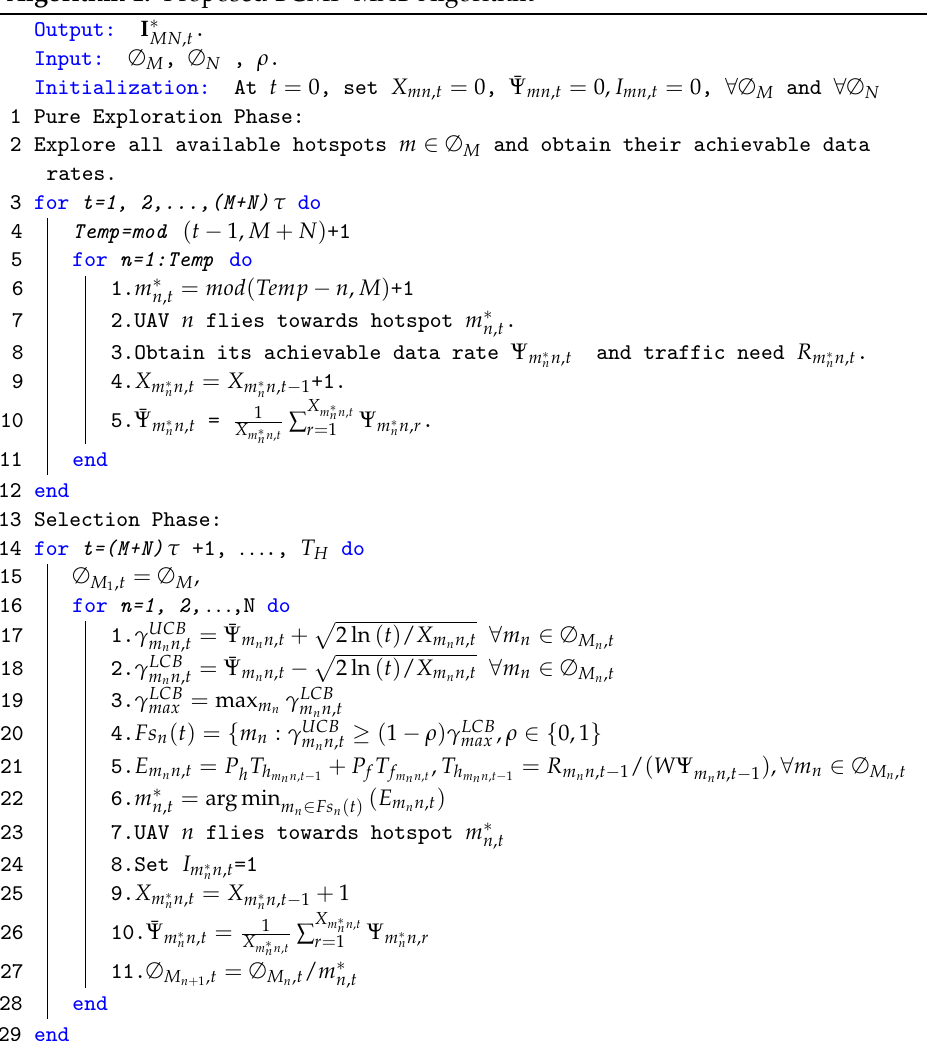
Algorithm 1: Proposed BCMP-MAB